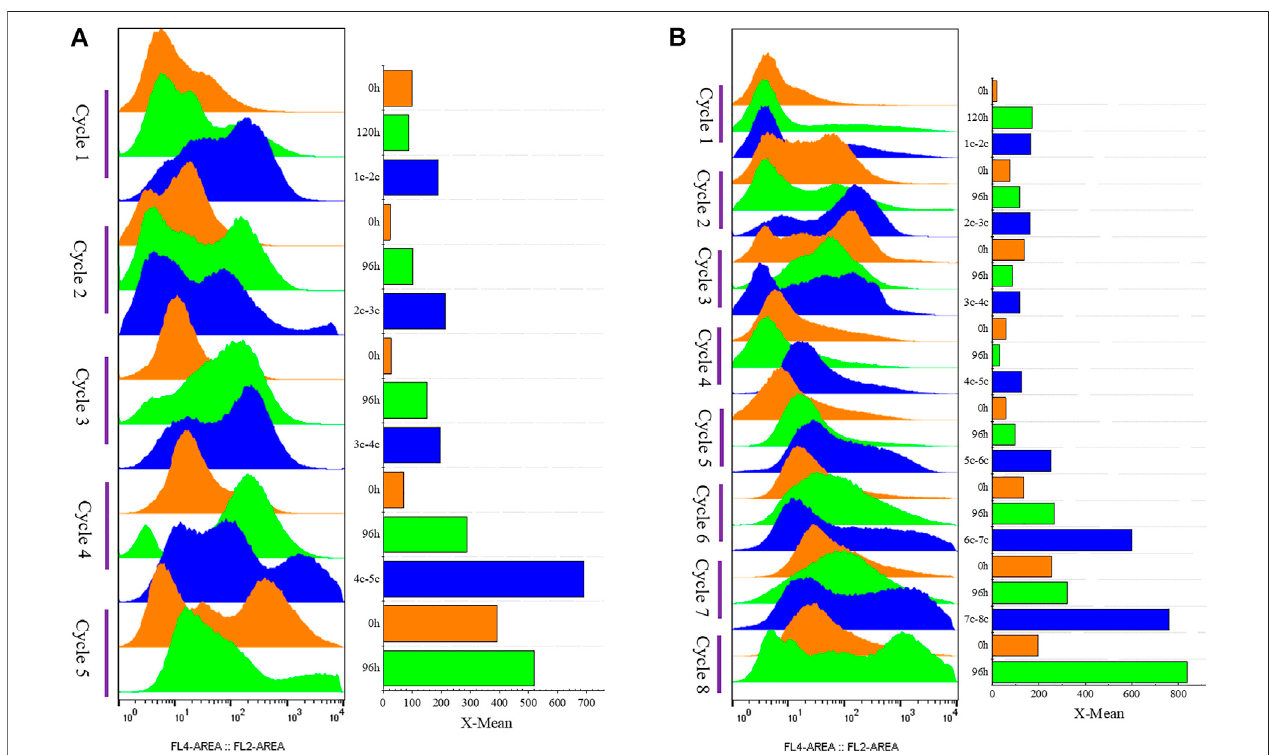
FIGURE8| CellvitalityofG/Pel.Y-axis:fermentationcycles;eachcyclecontainsthreepoints.0 h(orange),theviabilityofremainingcells(precipitatedcell);nc-n+1c (blue),theviabilityofcellswasremovedfromthepreviouscycle;120or96 h(green),thecellviabilityattheendofthefermentationcycle.X-axis:thecellviabilityvalues. (A) Semi-continuous cultivation with 200 mM Ca 2+ ions to accelerate G/Pel sedimentation to recycle cells. (B) Semi-continuous cultivation with 50 mM Fe 3+ ions to accelerate G/Pel sedimentation to recycle cells. The left side shows a histogram of fl ow cytometry, and the histogram migrates to the right, with increased fl uorescence and decreased cell vitality. The right side shows the statistical data of fl uorescence detected by fl ow cytometry at different time points.